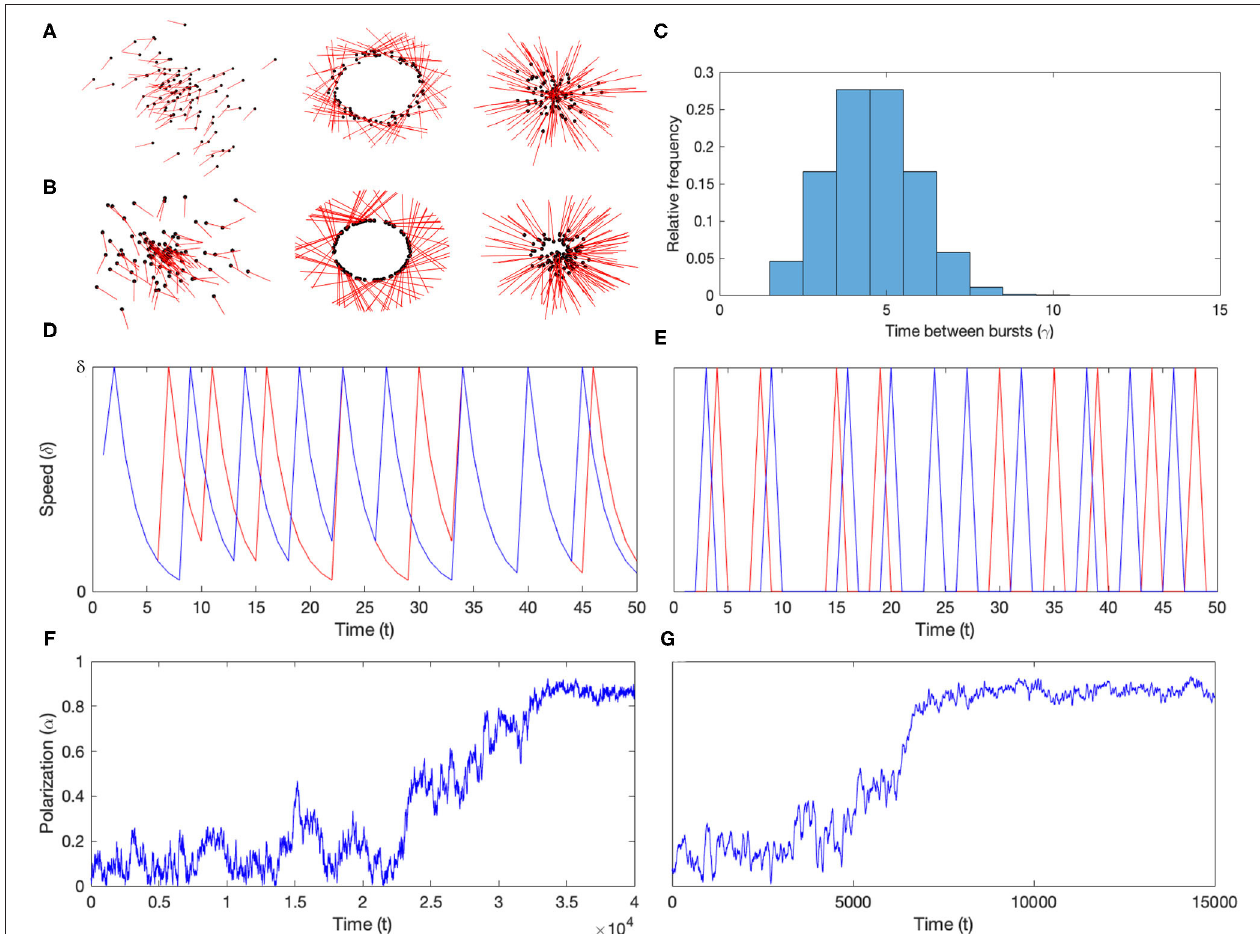
FIGURE 2 | Burst-and-glide and burst-and-stop simulations. (A) Group types produced in the burst-and-glide model (V). From left to right: polarized group ( c = 0.2), mill ( c = 1) and swarm ( c = 2). Points indicate particle positions and the red rods represent the current heading ˆ D i t of each particle. (B) Group types produced in the burst-and-stop model. From left to right: polarized group ( c = 0.2), mill ( c = 1) and swarm ( c = 2). (C) Common modified Weibull distribution ( Ŵ (4,3)) as measured in simulations. (D) Speed profiles of two particles in a burst-and-glide model simulation. We note the characteristic burst-and-glide dynamics in both, with bursts to maximum speed ( δ ) and exponential decrease in speed between the bursts. (E) Speed profiles of two particles in burst-and-stop model simulation. We note the burst-and-stop dynamics in both, with bursts to maximum speed ( δ ) and speed 0 between the bursts. (F) Polarization curve through a simulation of the burst-and-glide model. At time 0 polarization is low and after about 2 × 10 4 timesteps polarization starts to build up and at 3.5 × 10 4 it begins to stabilize at around 0.85–0.9. (G) Polarization curve through a simulation of the burst and stop model. At time 0 polarization is low (uniformly random headings) and after about 5 × 10 3 timesteps polarization starts to build up and at 7 × 10 3 it begins to stabilize at around